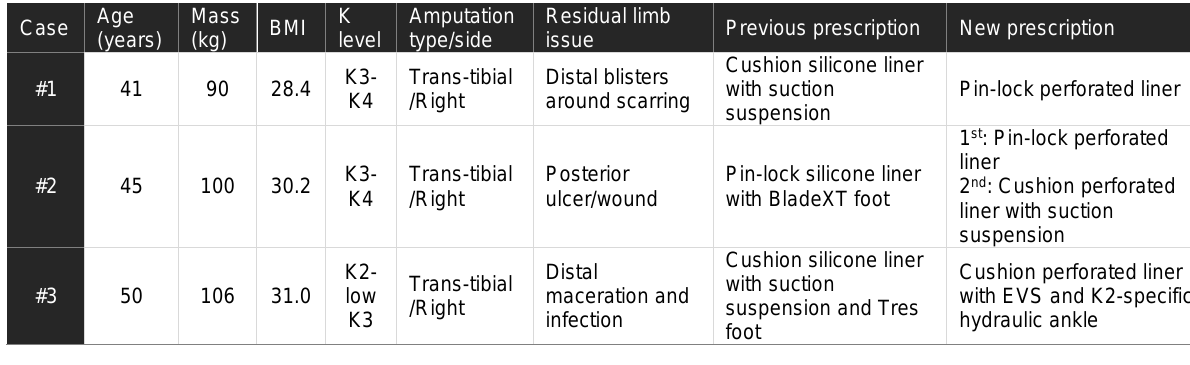
Table 1: Summary table of the cases